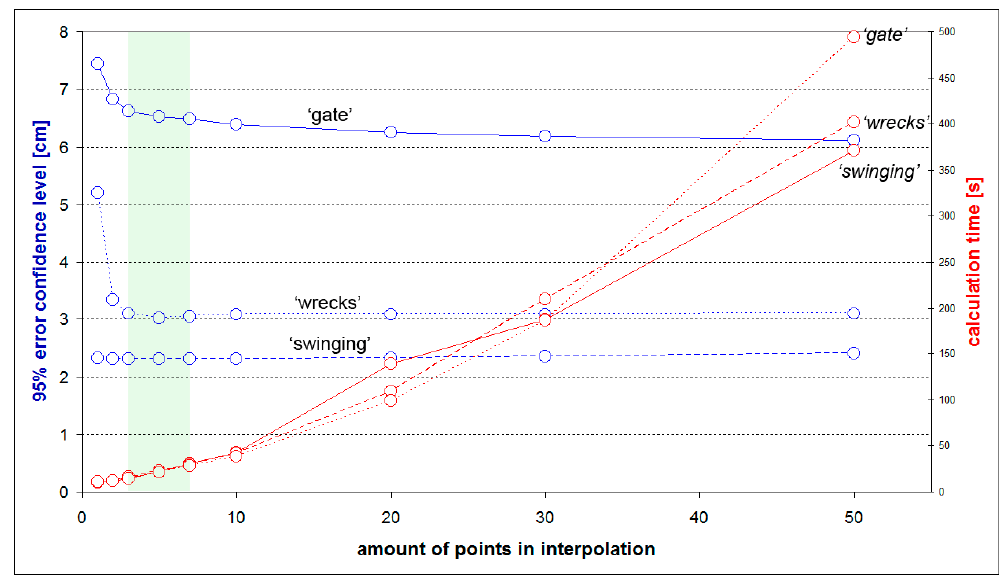
Figure 8. Kriging results for all three tested surfaces for different numbers of points.